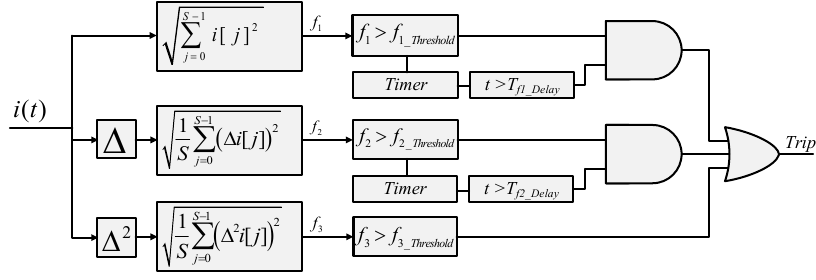
Figure 3. Block diagram of feature extraction from current signal and trip signal generation